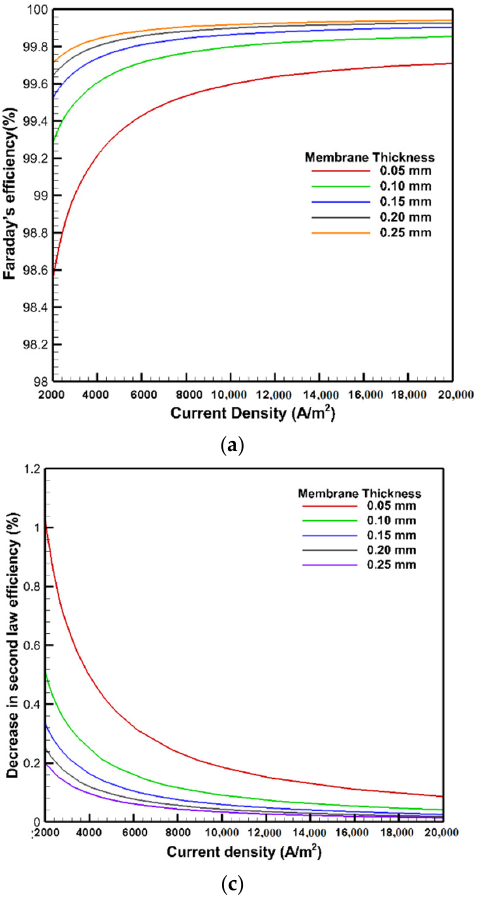
Figure 11. Effects of membrane thickness on: ( a ) Faraday’s efficiency; ( b ) the increase in exergy destroyed; ( c ) the decrease in second law efficiency; and ( d ) the increase in hydrogen exergy cost.